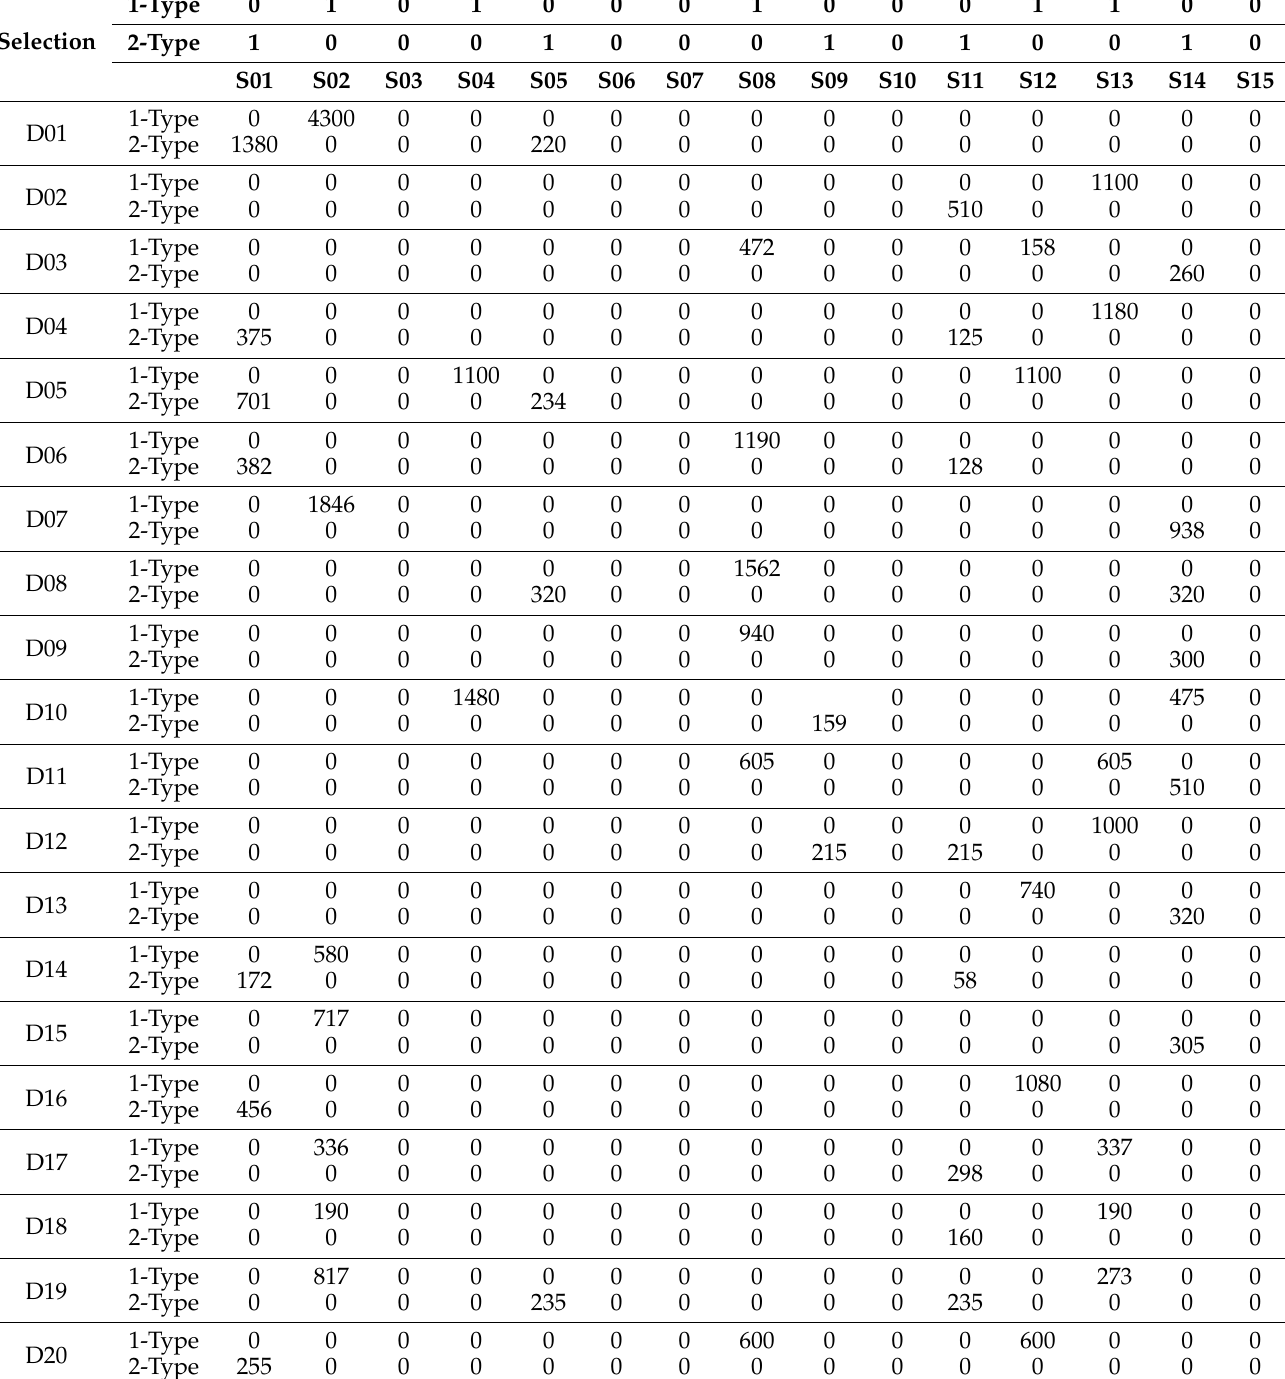
Table 16. The plan obtained under the best suitability of emergency